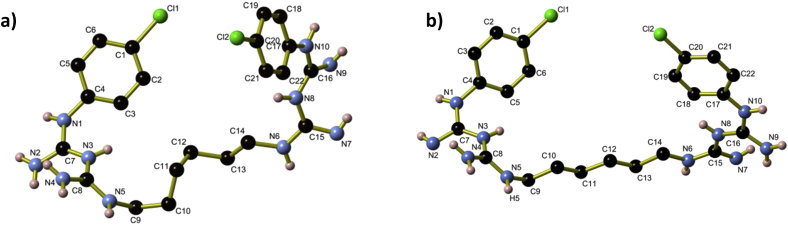
A view along the chlorhexidine cation found in a) (H2CHx)(SO4)·3H2O and b) (H2CHx)(CO3)·4H2O. Aromatic and aliphatic hydrogen atoms have been omitted for clarity.